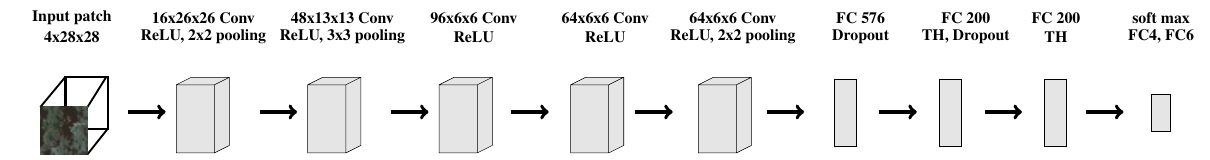
Figure 3: A brief illustration of the AlexNet model which was employed here. The network takes as input patches of 4x28x28 (dimen- sions). The network consists of 5 convolutional, 3 fully connected layers and 6 transfer function. A 4 or 6 way soft-max layer is applied depending on the dataset.